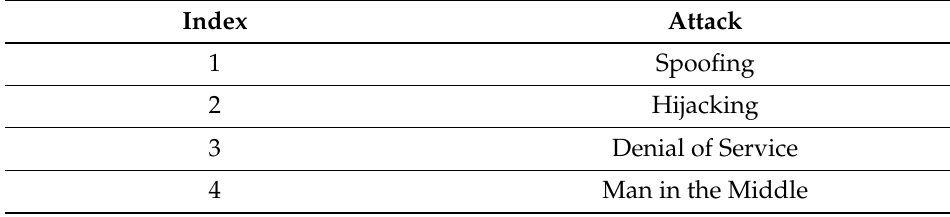
Table 2. External attacks considered (evaluation).